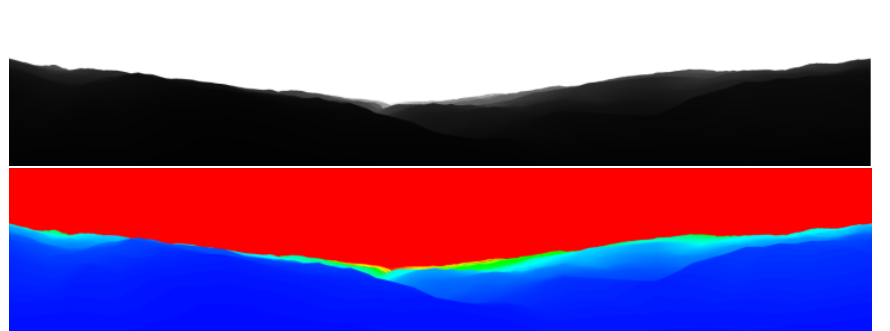
Figure 32. Rendering of DEM skyline generated by 3D model: ( Top ) Rendering of skyline generated from DEM data at selected sampling points, where the white area is the sky, the non-white area is the peak, and the gray scale represents the distance between the mountain and the observation point; ( Bottom ) pseudo-color map of ( Top ) to facilitate the viewing of details of the